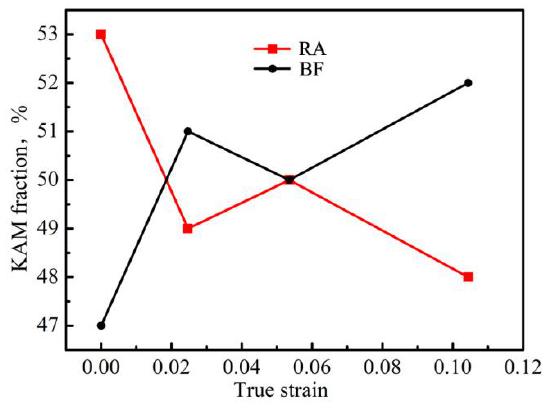
Figure 11. Variation in KAM fraction for each phase, with true strains.